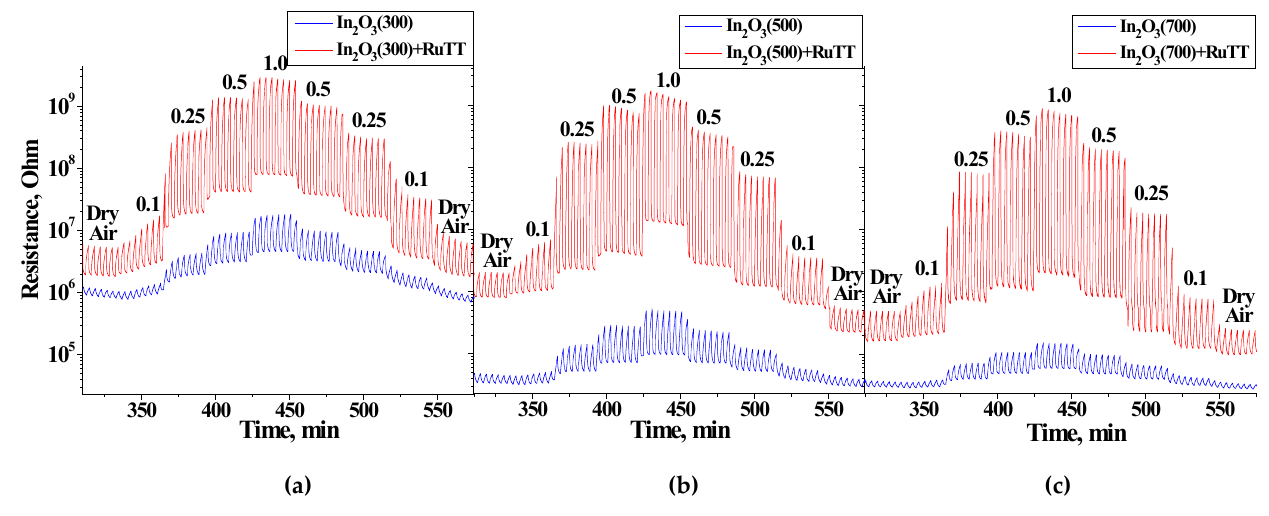
Figure 8. Change in resistance of the pure oxides and hybrid materials under periodic illumination with blue LED in the presence of various NO 2 concentrations for ( a ) In 2 O 3 (300) based, ( b ) In 2 O 3 (500) based, ( c ) In 2 O 3 (700) based samples.